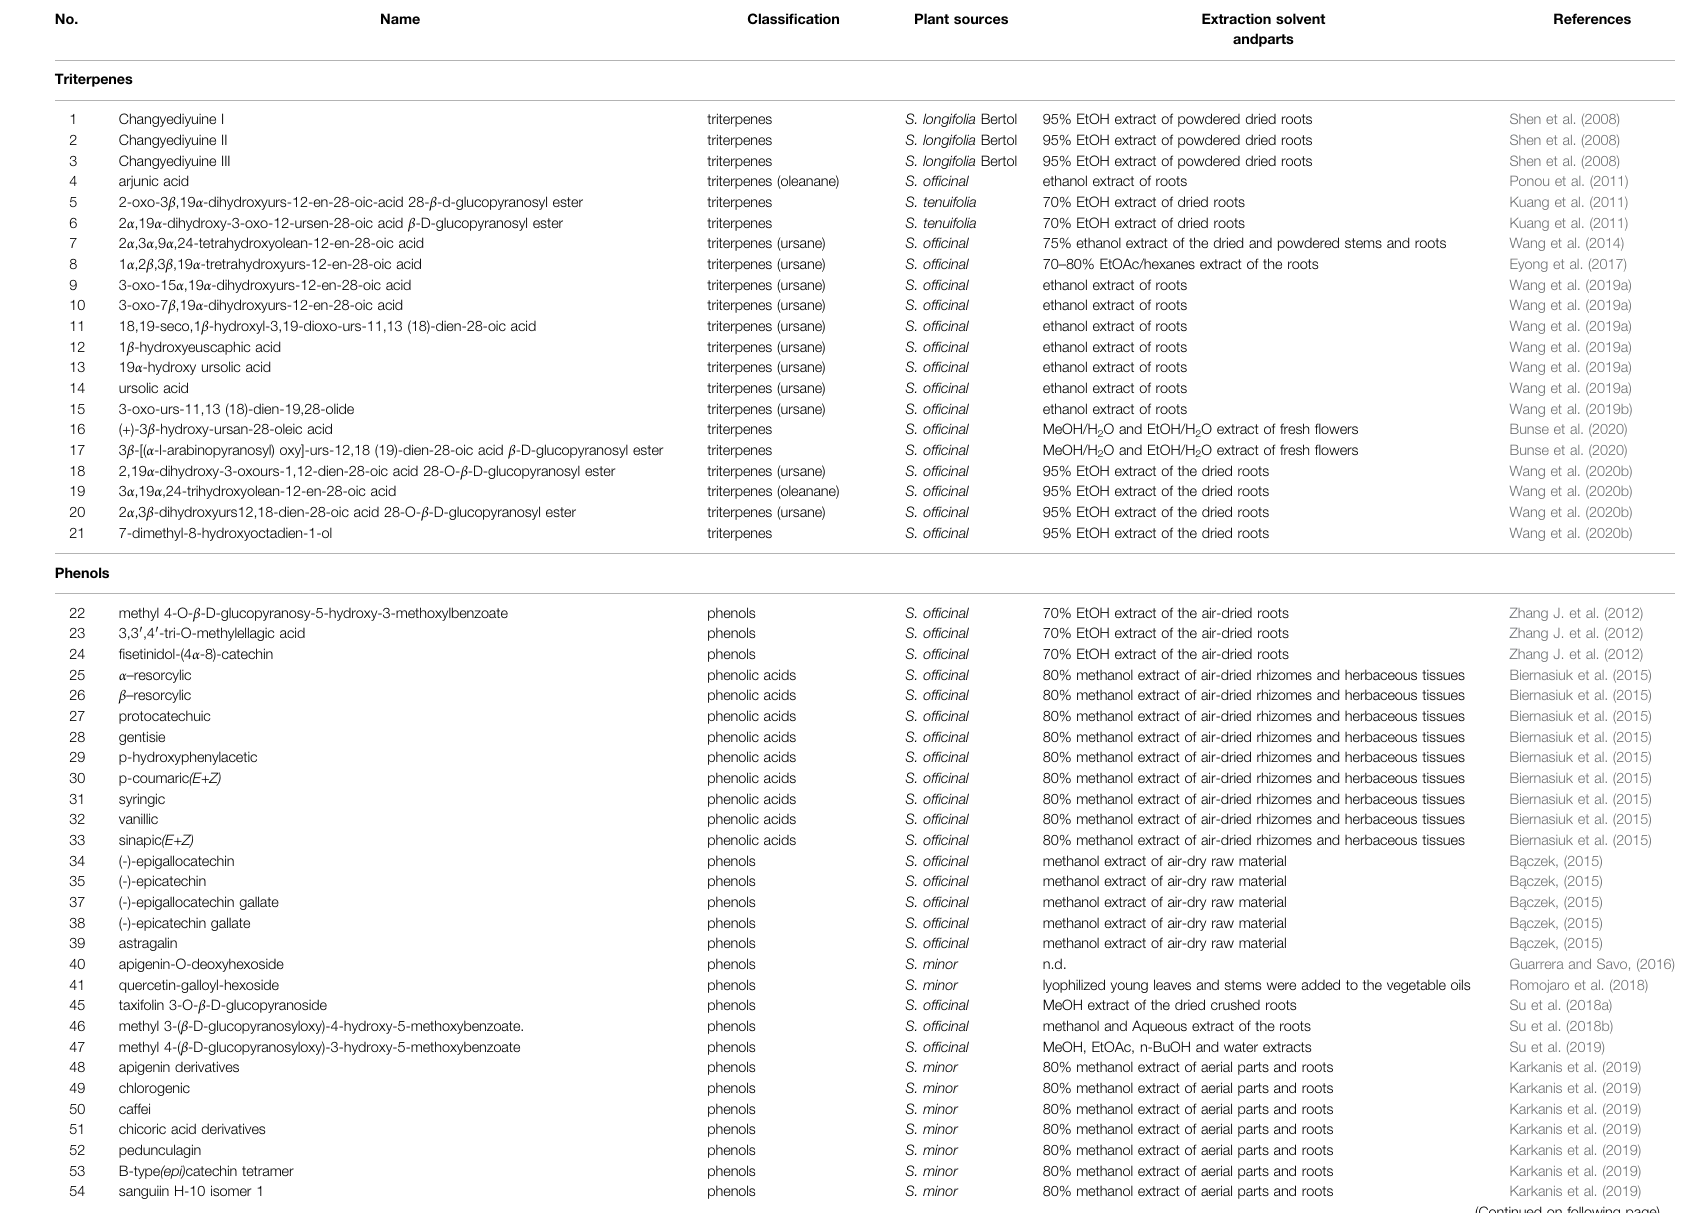
TABLE 1 | Chemical constituents in the genus Sanguisorba (2008 –